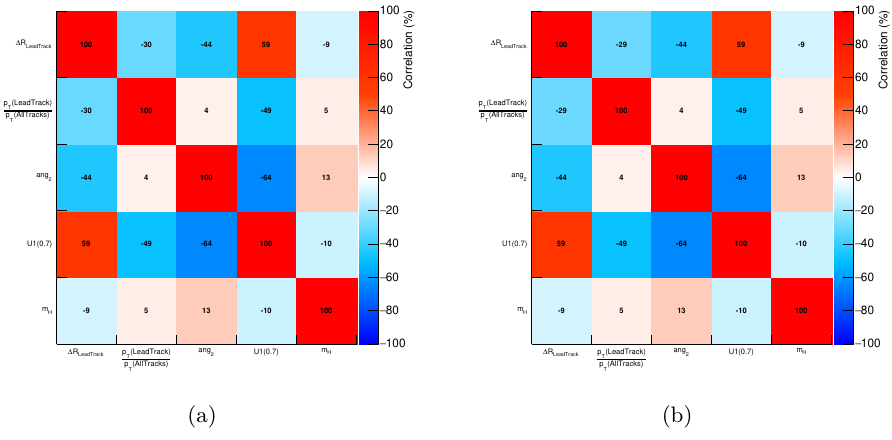
Figure 14 . Correlation matrix (a) from the data and (b) from the cGAN.